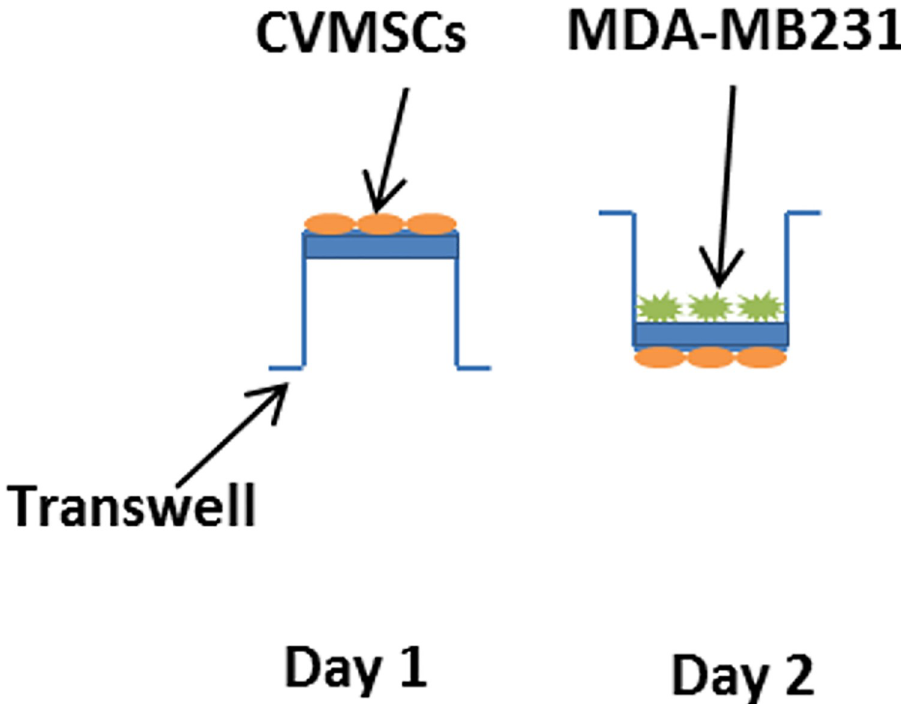
Fig 12. A direct contact between CVMSCs and MDA-MB231 through a transwell membrane. CVMSCs were incubated overnight on the underside of the transwell. After 24 h the transwell was flipped over and MDA-MB231 cells were added on the upper chamber of the transwell and incubated for